Question: Does the plotted quantity increase or decrease?
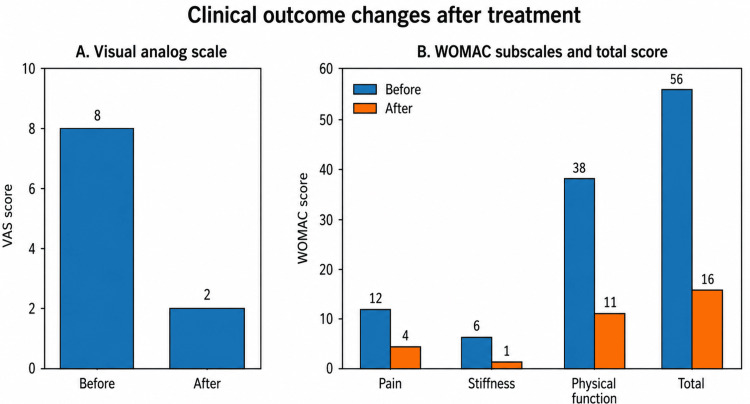
Answer: decreasing